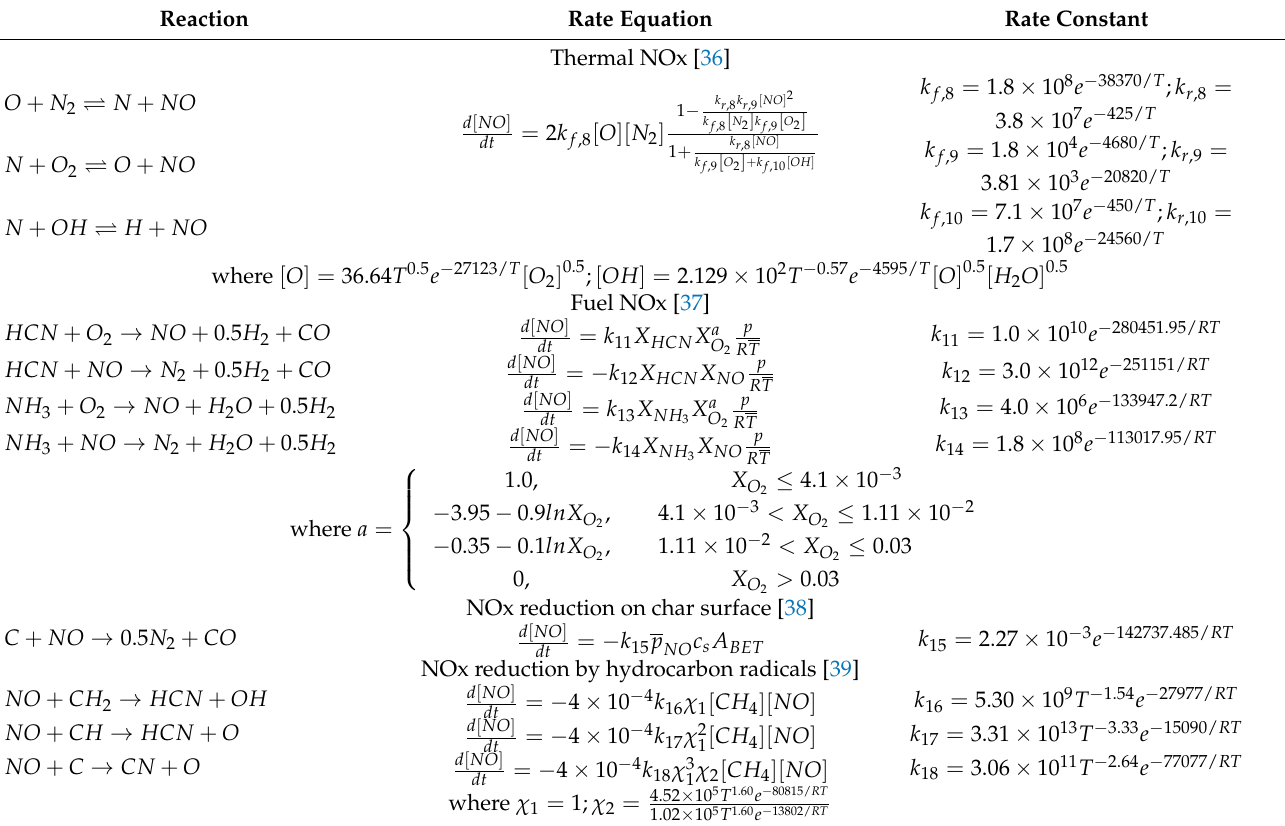
Table 3. NOx reactions with the kinetic